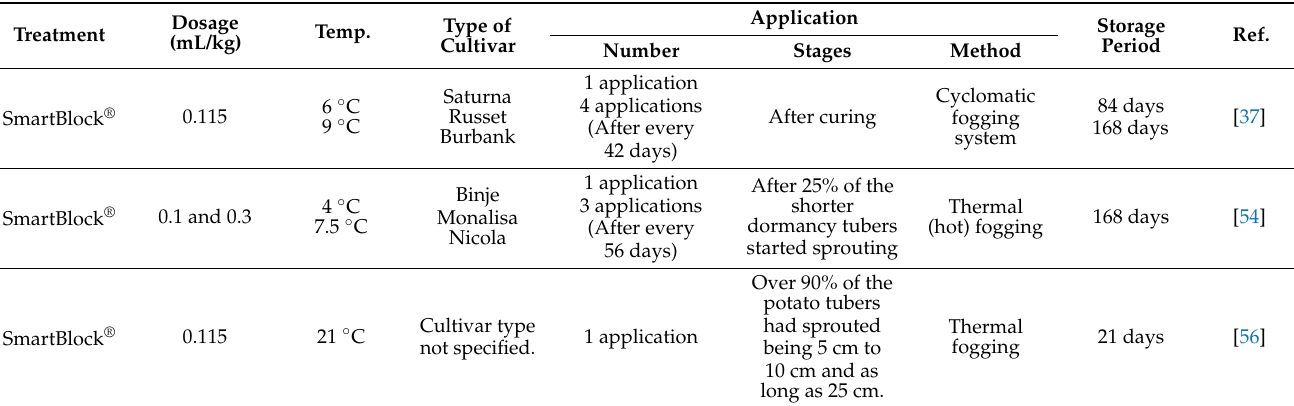
Application Storage